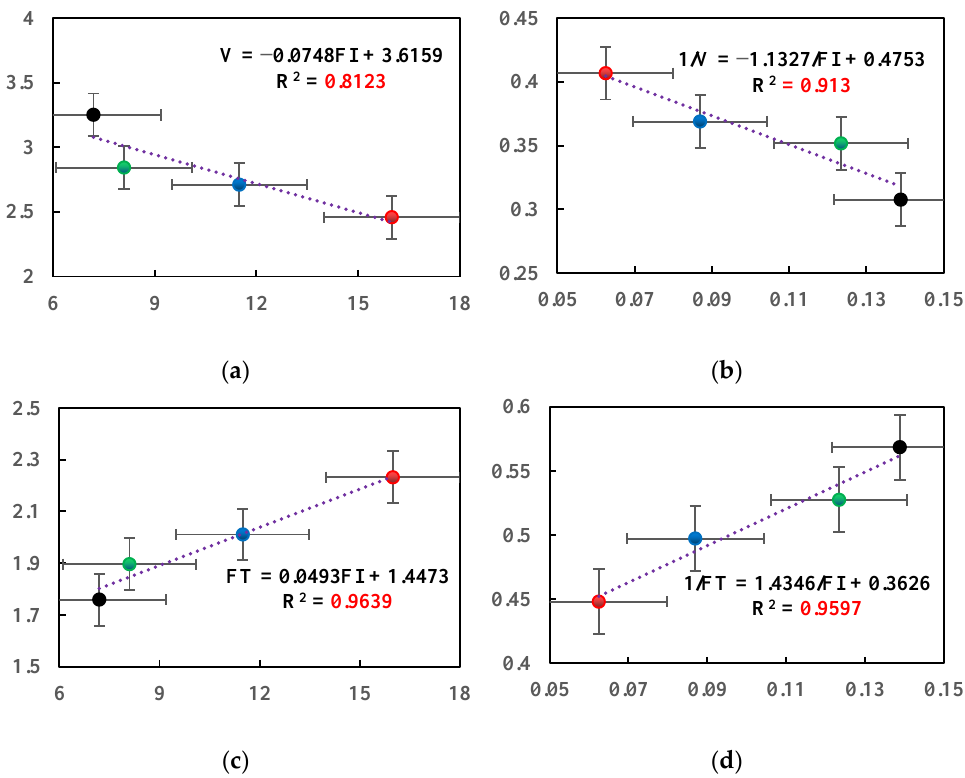
Figure 18. Index correlation analysis: ( a ) linear fitting of FI and V; ( b ) linear fitting of 1/FI and 1/V; ( c ) linear fitting of FI and FT; ( d ) linear fitting of 1/FI and 1/FT.